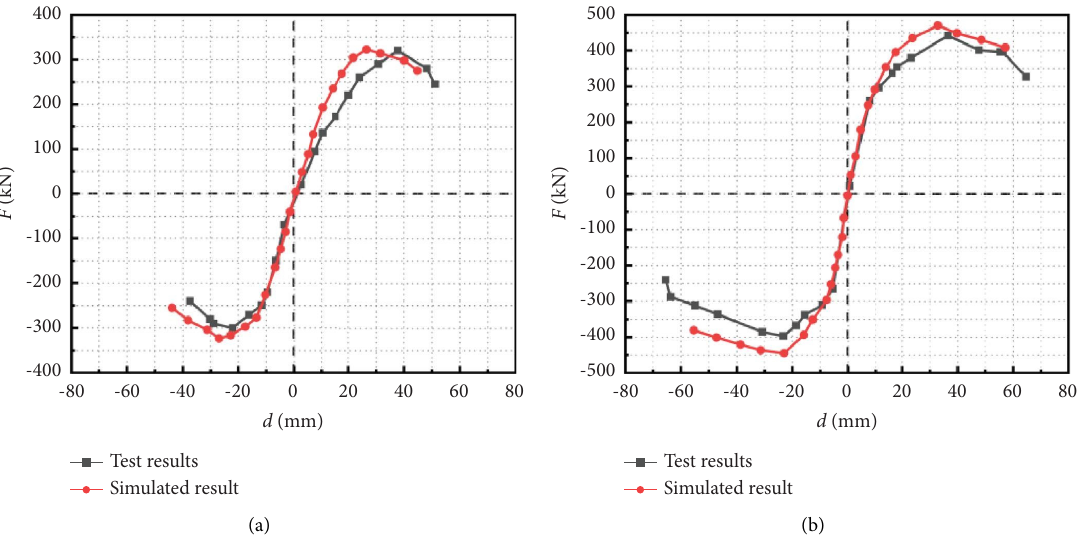
Figure 26: Comparison of simulation and test skeleton curves. (a) URC-1. (b) URC-2. Table 6: Comparison of the fnite element analysis value and test value of each load point. Specimen